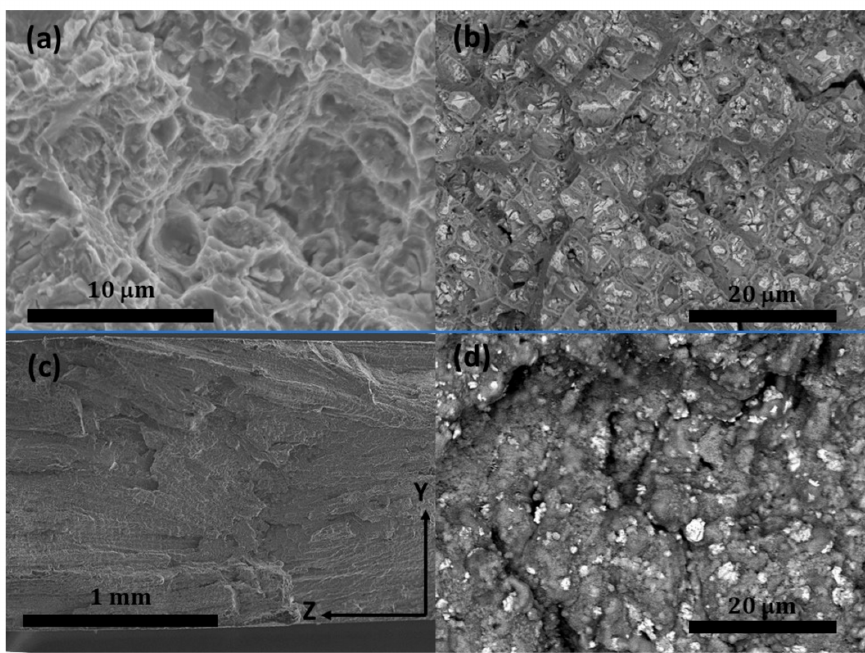
Figure 11. Fractographs of tensile testing samples of LDEDed 4275M72 depicting ( a ) a secondary electron (SE) image and ( b ) a backscattered (BSE) image of samples tested at room temperature, and ( c ) SE image and ( d ) BSE image of the sample tested at 1366.5 K.